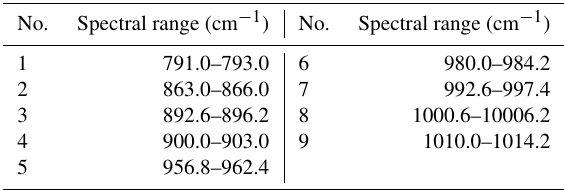
Table 1. Spectral windows for 3-D retrieval.